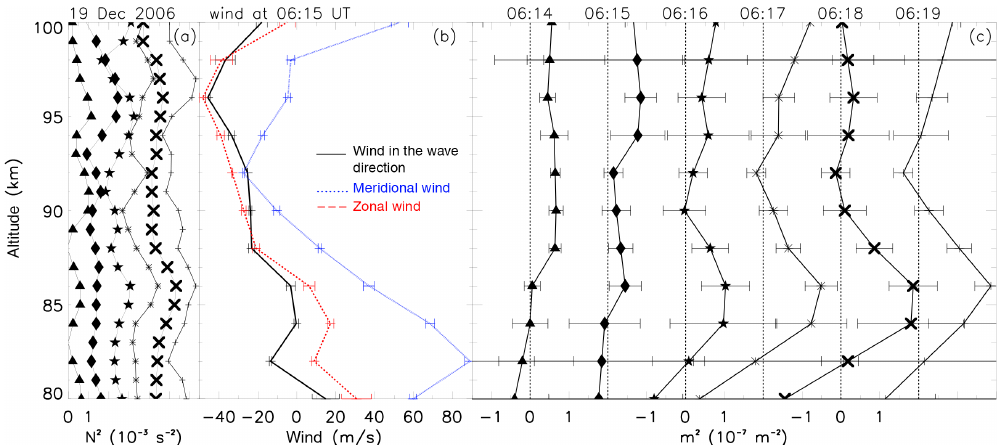
Figure 4. (a) Vertical profiles of the buoyancy frequency. (b) Meridional (dotted line), zonal (dashed line) and wind in the direction of the wave (solid line) at 06:15 obtained from the meteor radar. Error bars represent the uncertainties in the determination of the winds. (c) Square of the vertical wave number calculated using Taylor–Goldstein dispersion relation. Error bars represent the uncertainties in the estimation of the m 2 from the second differentiation of the